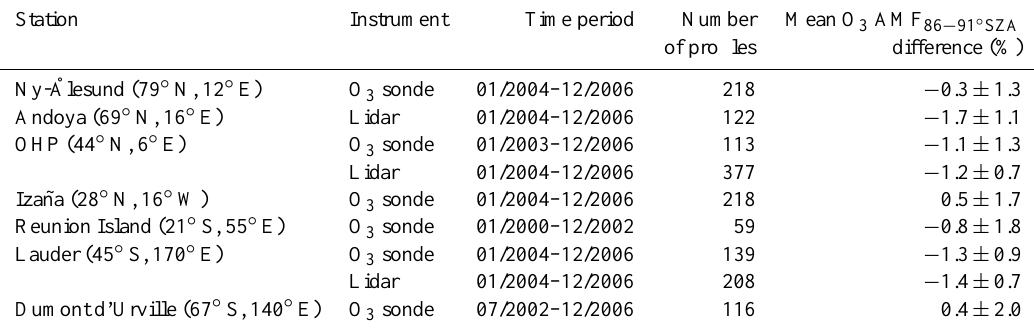
Table 3. List of O 3 profile measurements used for testing the validity of the TV8 climatology for O 3 AMF calculations. The last column is the mean relative difference (and the corresponding 1 σ standard deviation) between O 3 AMF 86 − 91 ◦ SZA extracted from the LUTs and calculated using the O 3 profiles measured at the different NDACC stations (see Fig. 4).